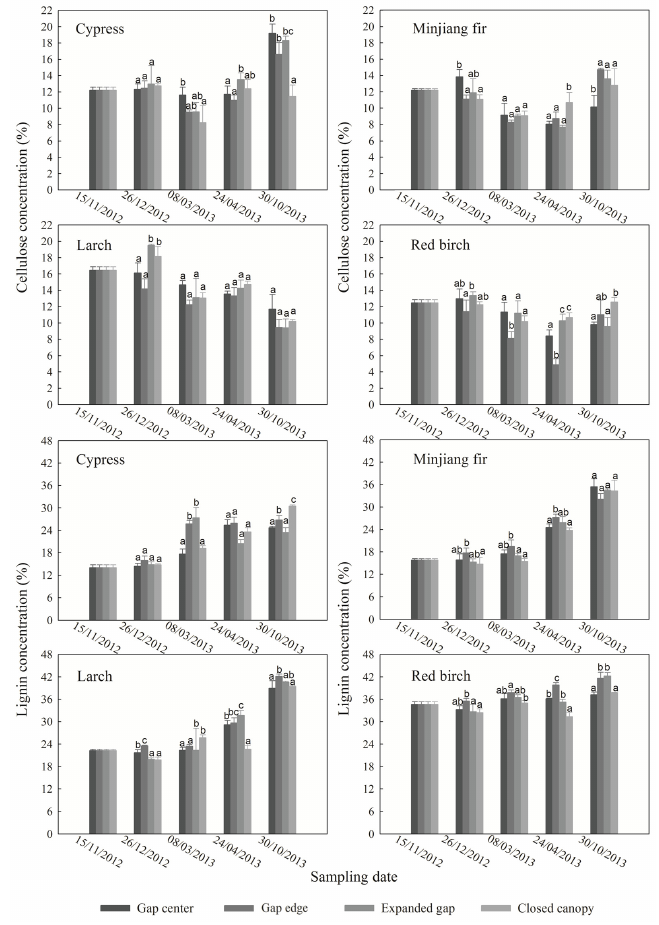
Figure 3. Cellulose and lignin concentrations (%) in the four types of foliar litter (cypress, Minjiang fir, larch, red birch) in the four gap positions (gap center, gap edge, expanded gap, closed canopy) at each sampling time (the end of each critical period) over the first year of litter decomposition in an alpine Minjiang fir forest. Different lowercase letters indicate significant differences among gap positions for the same sampling date, p < 0.05 (mean ± SE, n = 3). At the snow formation period, there were no significant differences among gap positions in the absolute change percentages of cellulose or lignin for cypress and red birch, and lignin for Minjiang fir. In this latter species, cellulose accumulation was observed at the gap center in contrast to the other gap positions. Over the winter, the litter exhibited both higher absolute cellulose losses and absolute